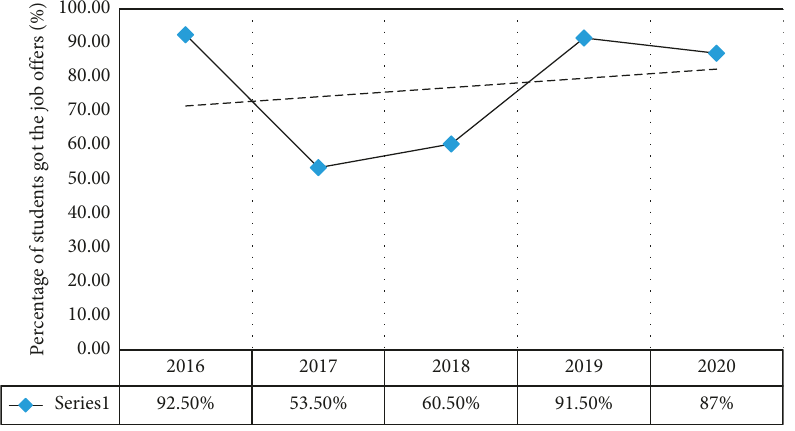
Figure 3: Placement scenario for advanced learners.